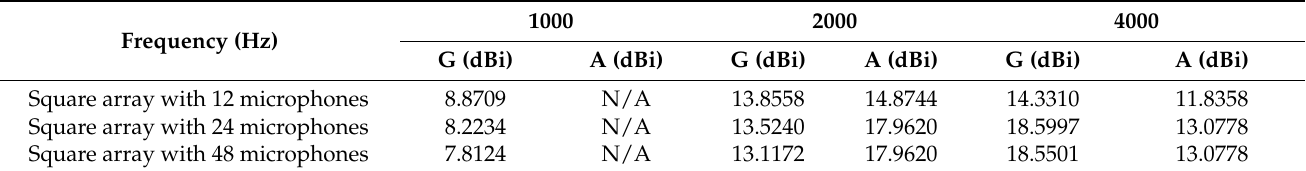
Table 5. Signal gain and attenuation for each square array version.